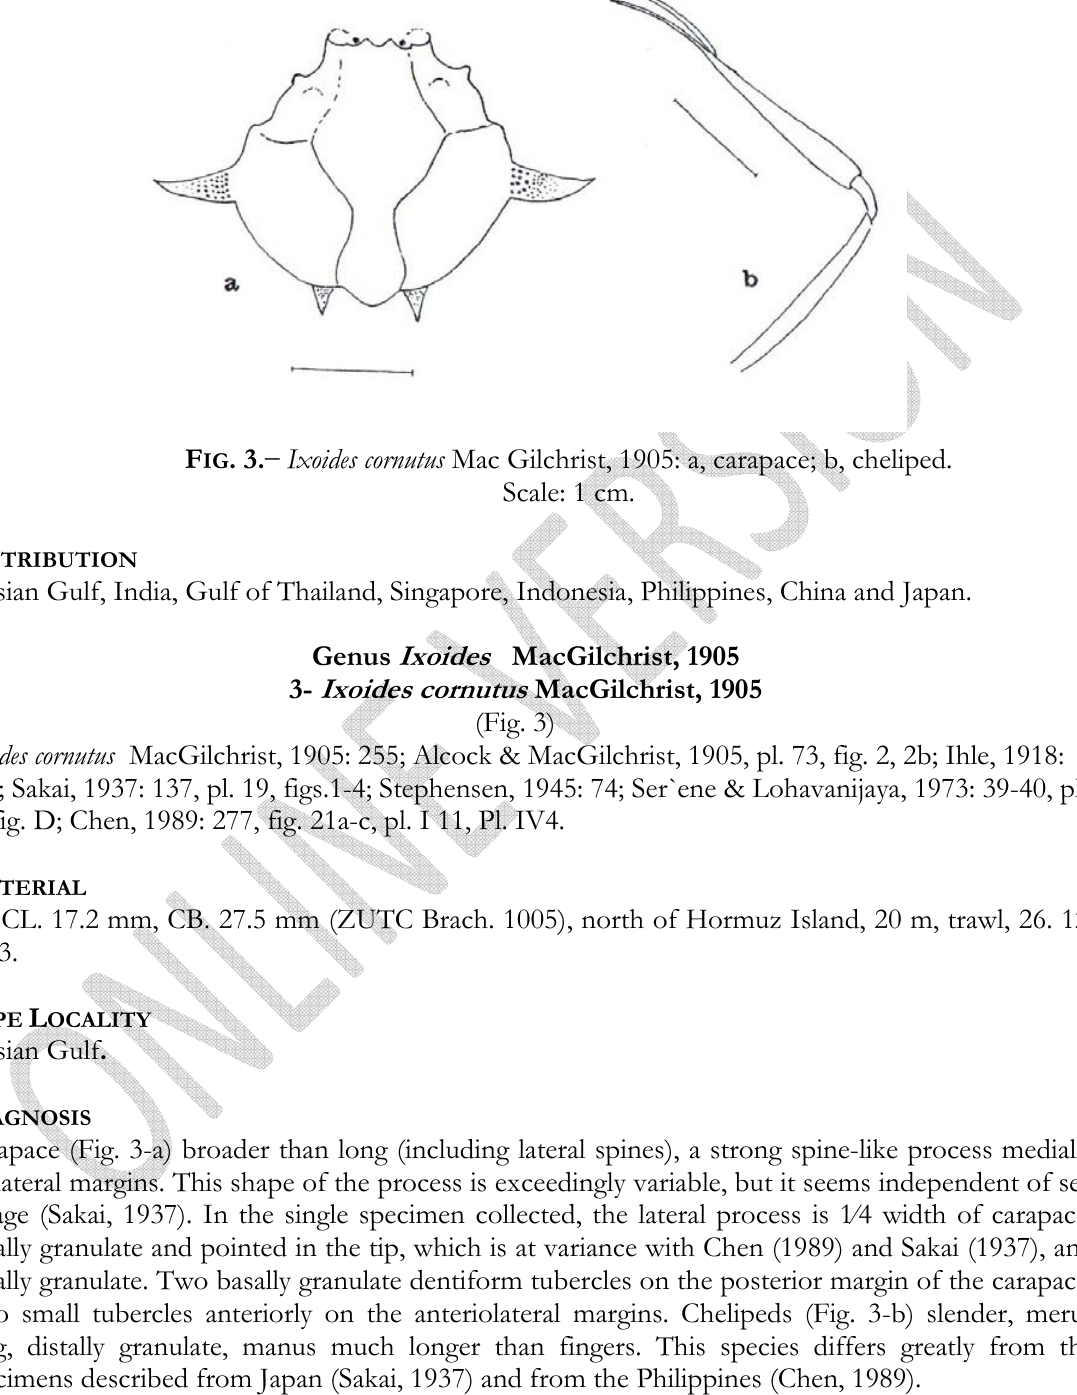
3._ Ixoides cornutus Mac Gilchrist, 1905: a, carapace; b, cheliped. F IG . Scale: 1